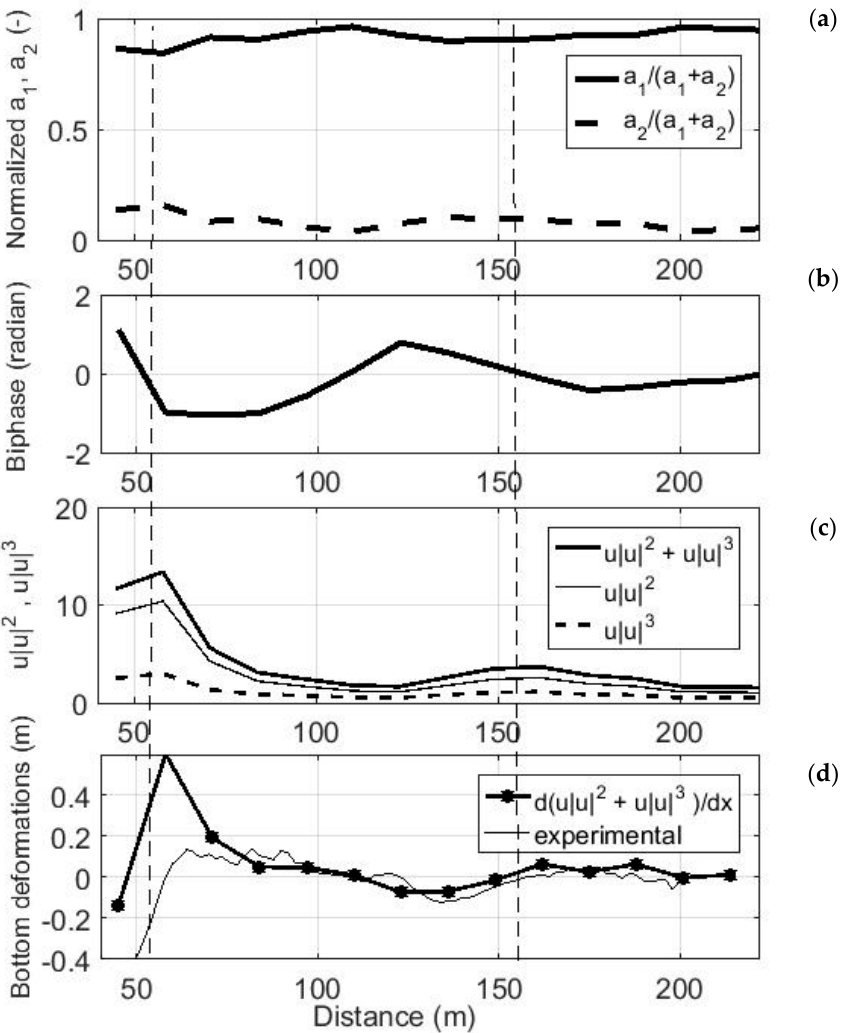
Figure 6. The evolution of normalized amplitudes of first and second non-linear harmonics ( a ), biphase ( b ); the third and fourth moments of the orbital near-bottom velocity ( c ) calculated with the use of Formulas (3) and (4) for the wave situation (series 42) on 29 September. Calculated deformations of the bottom relief and moving averaged difference in measured profiles between 28 and 29 September ( d ).